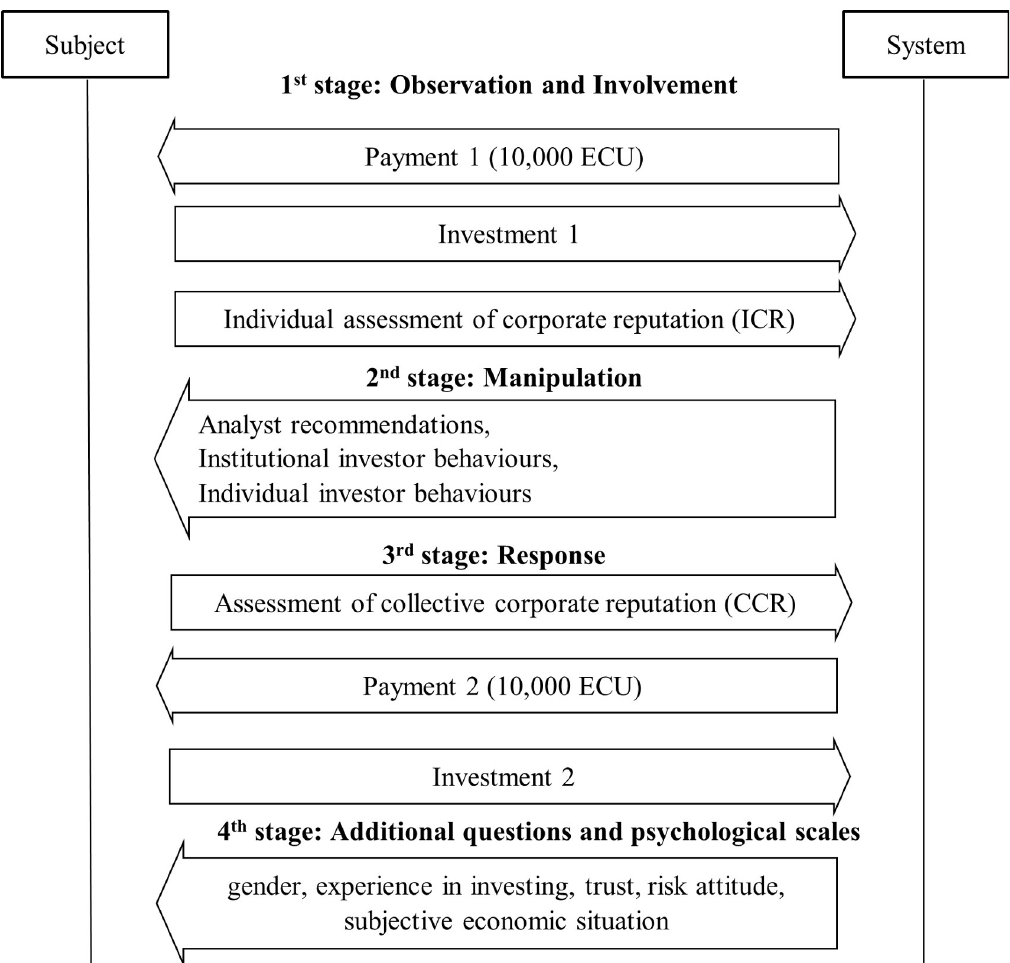
Fig 2. Experimental design: Timeline and information flow between the subject and the